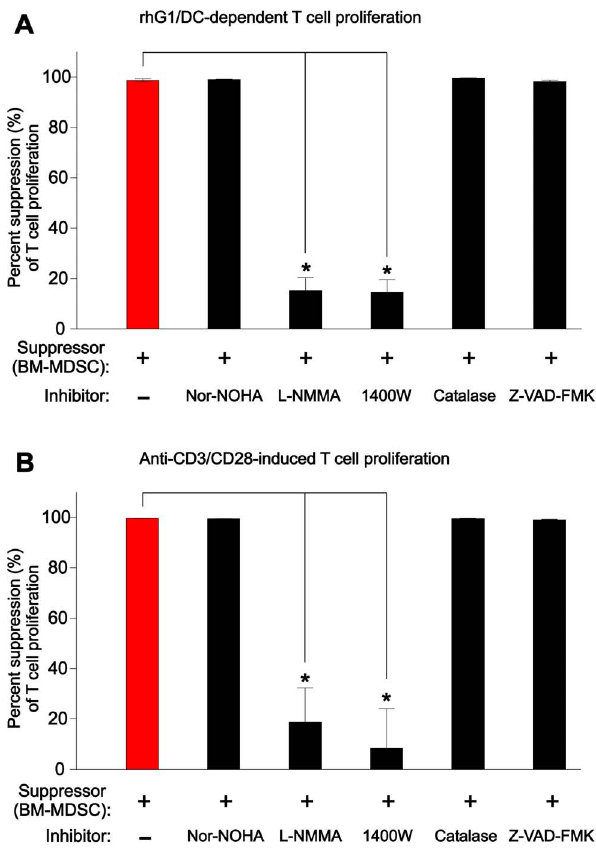
Figure 3. Reversal of the suppressive effect of BM-MDSCs on T- cell proliferation by inhibitors of inducible nitric oxide synthase (iNOS). Various inhibitors of MDSC effector molecules, including the arginase 1 inhibitor nor-NOHA, iNOS inhibitors L-NMMA and 1400W, the reactive oxygen species (ROS) scavenger catalase, and the caspase/apoptosis inhibitor Z-VAD-FMK, were used to inhibit the BM-MDSC-mediated suppression of ( A ) Ag (rhG1)-induced/DC-depen- dent and ( B ) anti-CD3/CD28-induced proliferation of PG-TCR-Tg T cells. The results (compiled from 2 independent series of experiments, each with 2 co-cultures) are expressed as percent suppression of T-cell proliferation in the presence (black bars) or absence (red bar) of inhibitors. While suppression of T-cell proliferation in both induction systems was significantly reversed by the iNOS inhibitors L-NMMA and 1400W (*p , 0.0001 in all cases; Kruskal-Wallis test followed by Dunn’s multiple comparisons test), none of the other inhibitors had a significant effect on BM-MDSC-mediated suppression of T